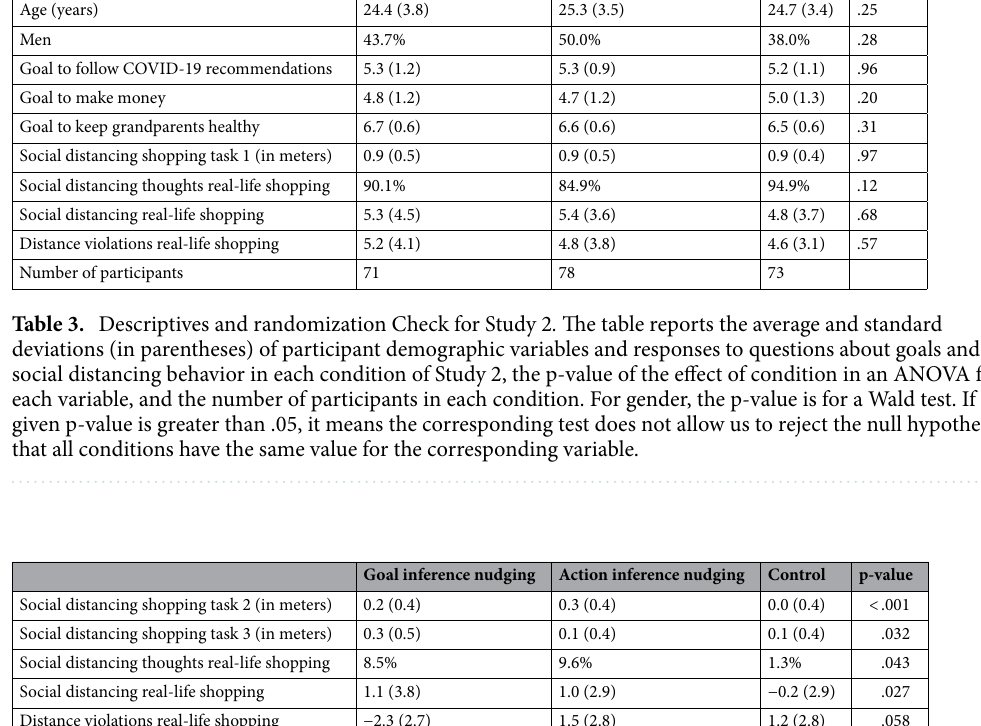
Table 4. Means, SDs, and regression-estimated effects of condition for increases in social distancing behavior and distance violations compared to baseline in Study 2. The table reports the average and standard deviations (in parentheses) of increases in social distancing behavior compared to baseline in Study 2 and the p-value of the effect of condition in an ANOVA for each variable.